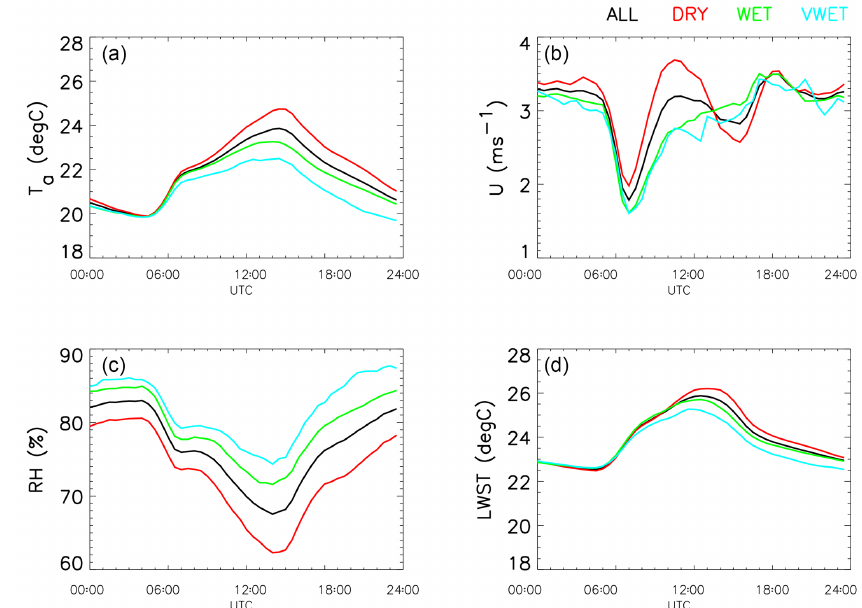
Figure 6. Mean diurnal cycles of (a) air temperature ( T a , ◦ C), (b) wind speed ( U , ms − 1 ), (c) relative humidity (RH, %) and (d) lake surface temperature (LWST, ◦ C) from the upwelling longwave irradiance, assuming an emissivity of 0.99. The input data are those from the 4 years 2013–2016 of the campaign to represent all seasons equally. The colours correspond to diurnal cycles averaged over ALL days (black), DRY days (red), WET days (green) and VWET days (cyan).